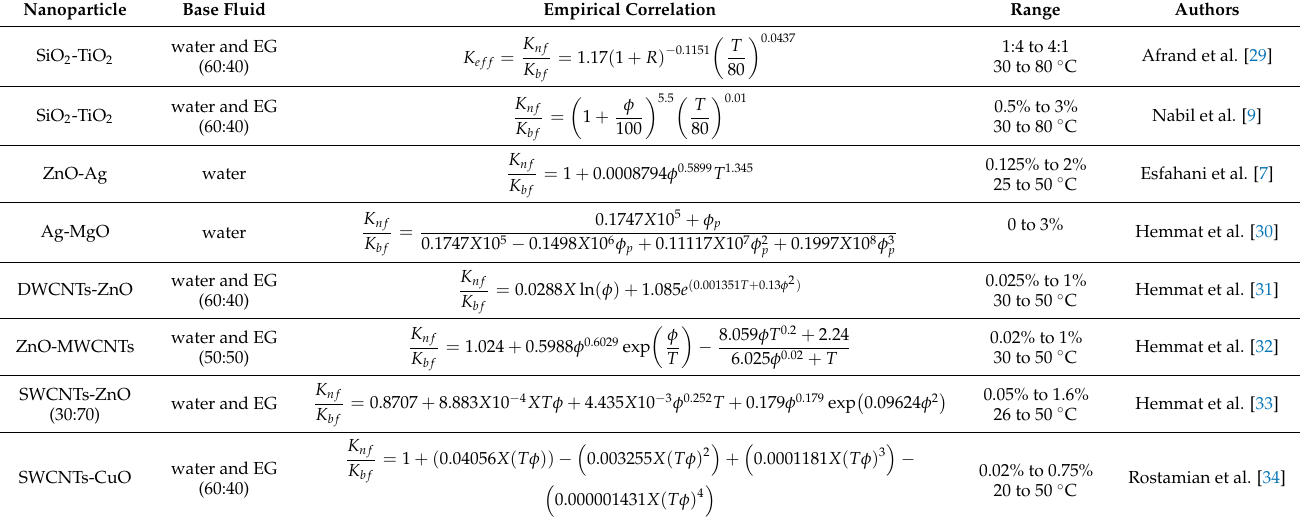
Table 1. Empirical correlations for the thermal conductivity of water-based hybrid